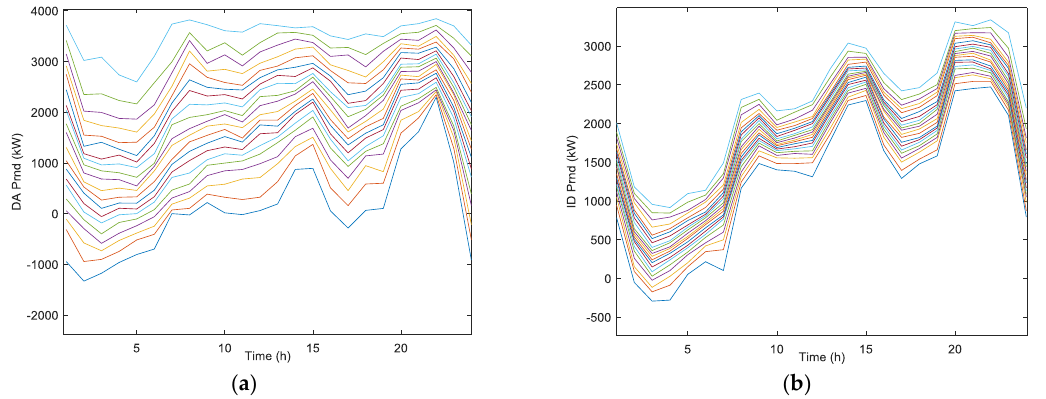
Figure 2. Basic trajectories of fixed demand, photovoltaics (PV), and wind power.